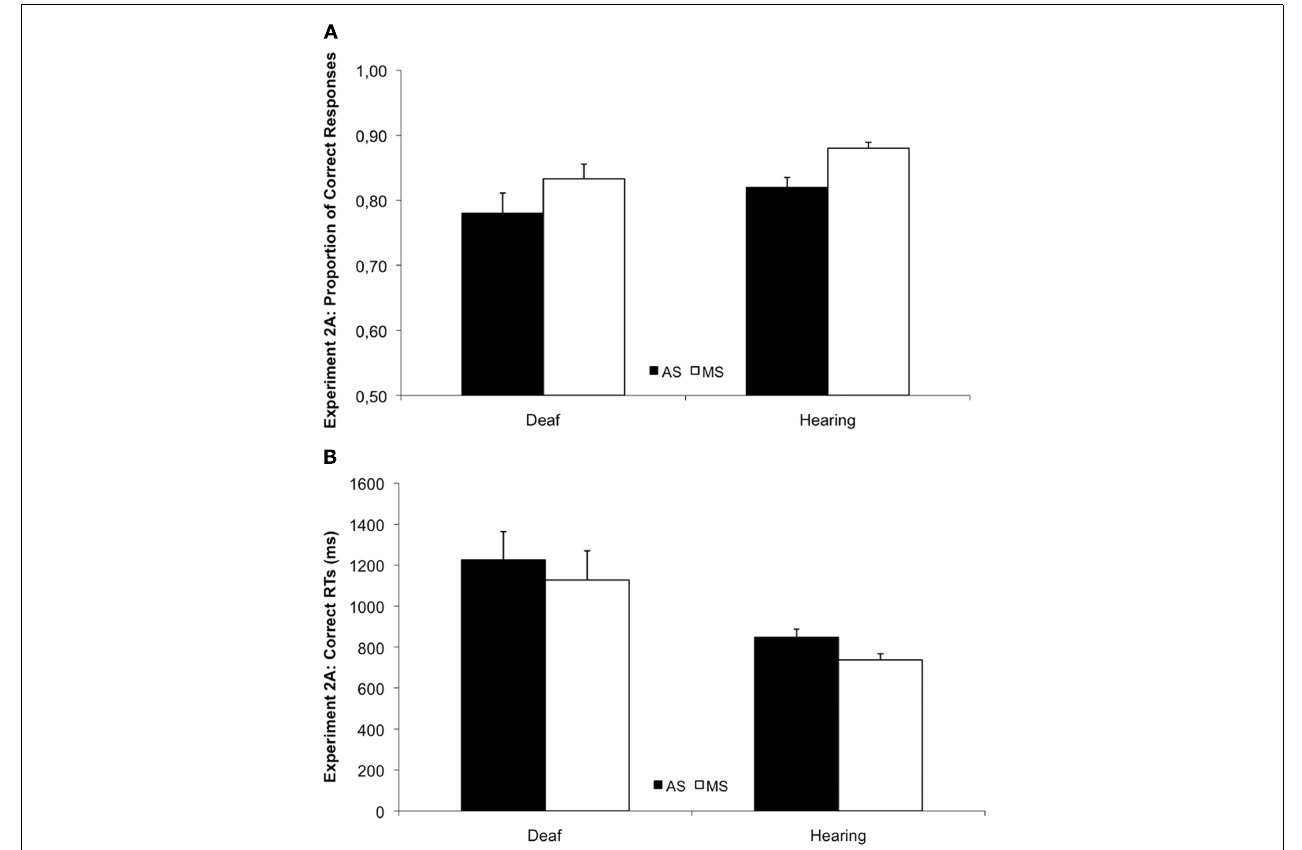
FIGURE 6 | Proportion of correct responses (A) and correct response times (B) of deaf and hearing participants when the locus of attention was the top parts of faces (Experiment 2A). Bars represent SEs.